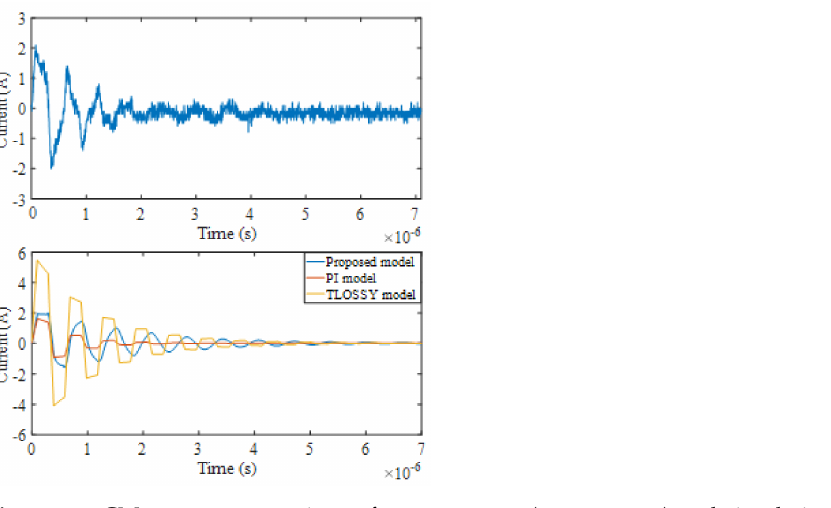
Figure 13. CM current comparison of measurement (upper curve) and simulation (bottom) for 20 m